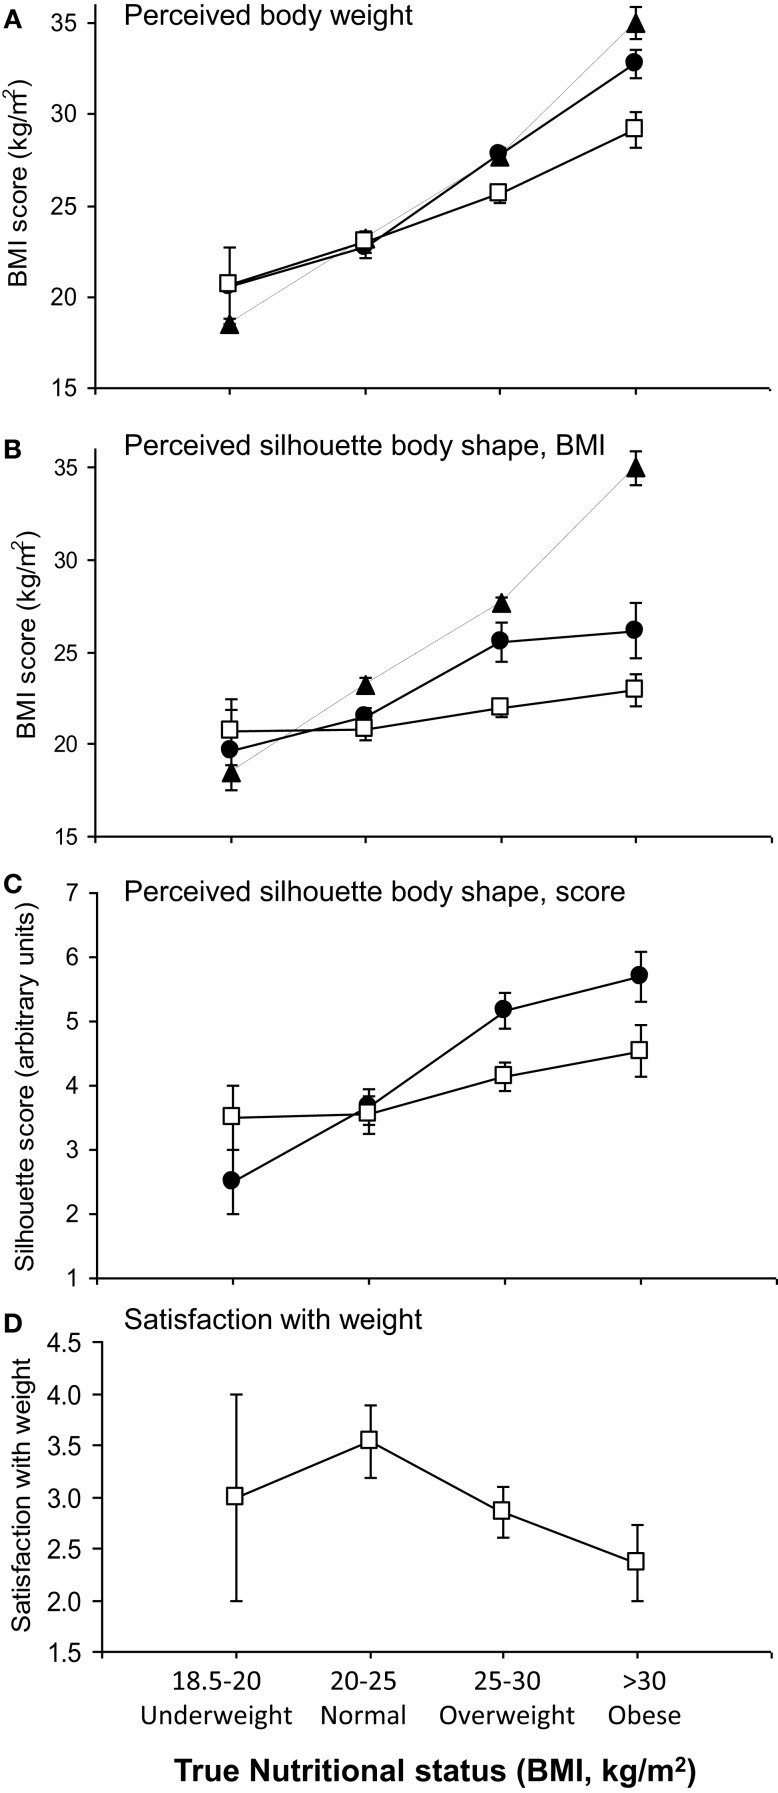
Relationship of perceived and ideal body size to current nutritional status. (A) Perceived body weight: True (filled triangles, dashed line), usual (filled circles), and ideal (open squares) body weight, expressed in kilograms (normalized to BMI) of patients according to current nutritional status category. “True” represents measured values, and “Usual” and “Ideal” were derived from questionnaire responses. (B) Perceived body shape from silhouettes corresponding to known BMI values (Series A) compared to true BMI (filled triangles). Data are shown for perceived “current” shape (filled circles) and “ideal” shape (open squares). (C) Perceived body shape from numbered silhouettes (Series B) expressed as “current” shape (filled circles) and “ideal” shape (open squares). (D) Subjects’ happiness with current body-weight scored from 1 to 5 (1, very unhappy; 2, unhappy; 3, not bothered; 4, happy; 5, very happy) according to current BMI category. All data shown are means ± 1 SEM.